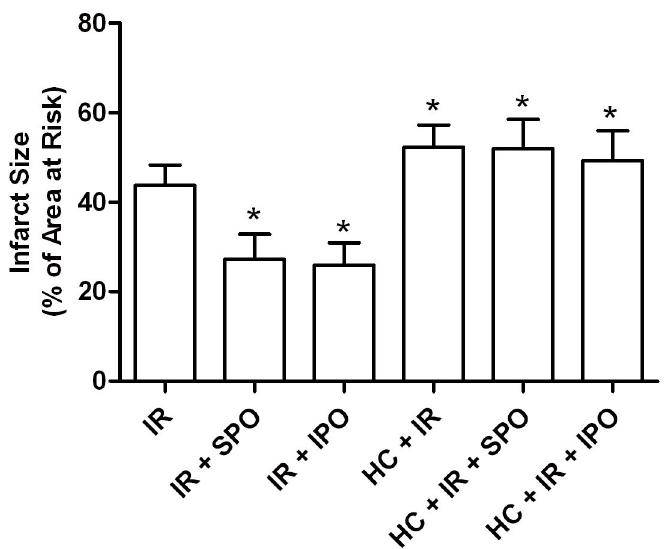
Figure 2. Effects of sevoflurane and ischemic postconditioning on infarct size expressed as a percentage of area at risk in rat hearts exposed to ischemia-reperfusion. IR: ischemia reperfusion; SPO: sevoflurane posconditioning; IPO: ischemic posconditioning; HC: hypercholesterolemia. Data are mean ± SD, n = 8 hearts/group. * P < 0.05 vs . IR.